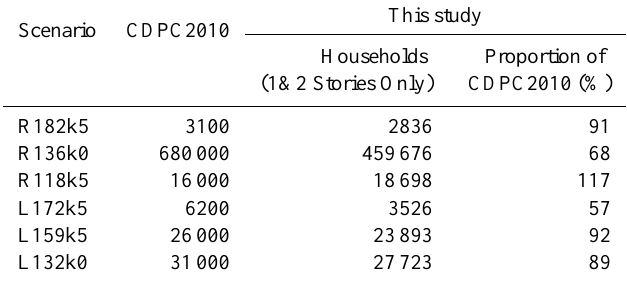
Table 1. Estimated numbers of households inundated above floor level. Proportions are rounded off to the nearest % point.